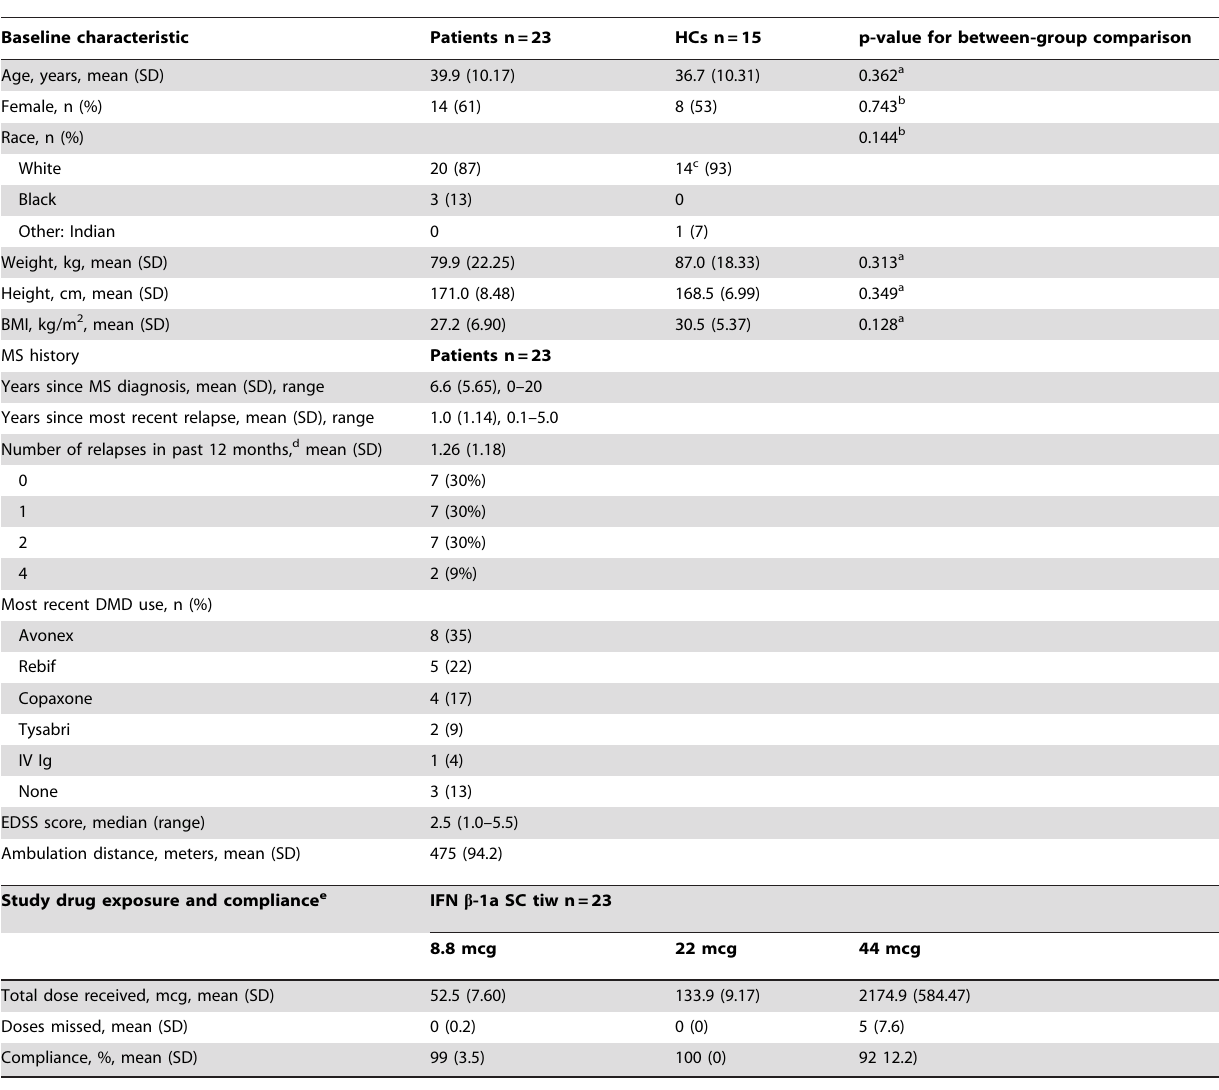
Table 1. Baseline characteristics of patients and of HCs and study drug exposure and compliance throughout the study.